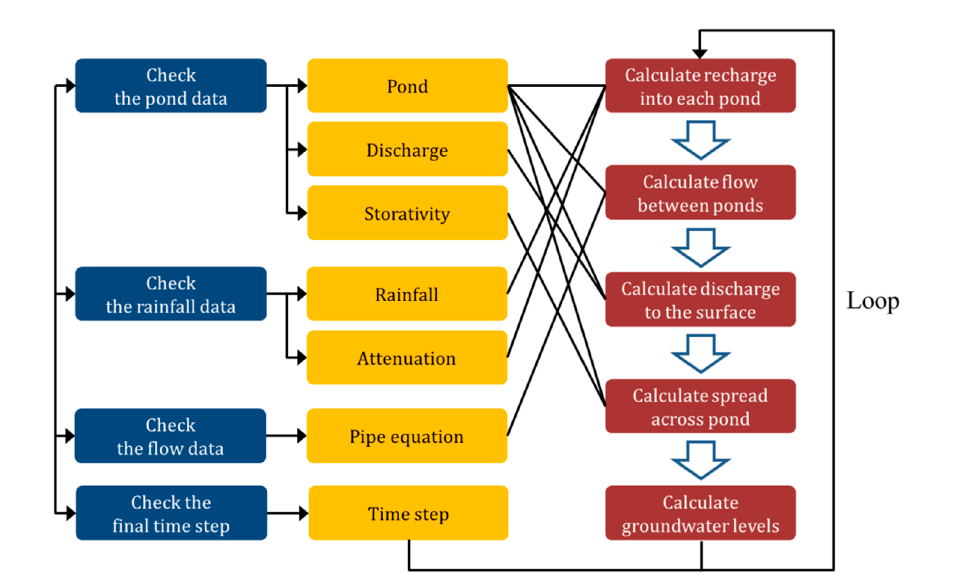
Figure 5. Flowchart showing the SIMPL program simulation engine module procedure.